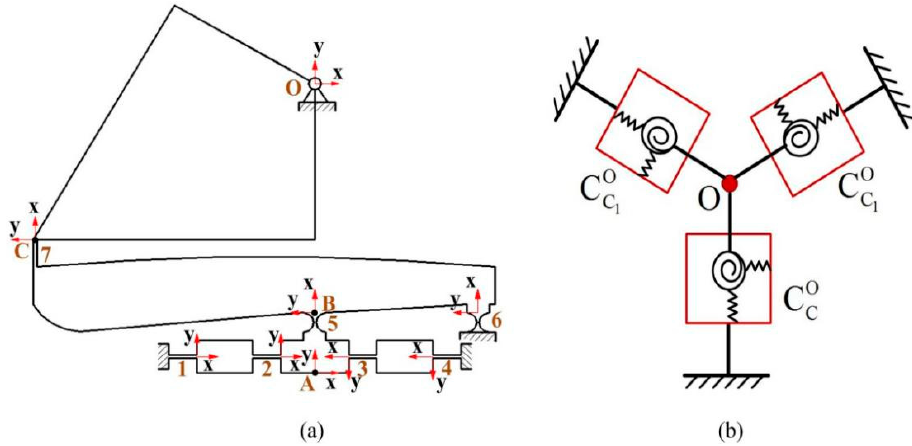
Figure 4. ( a ) Third of kinematic chains and ( b ) parallel spring model of the VPD.